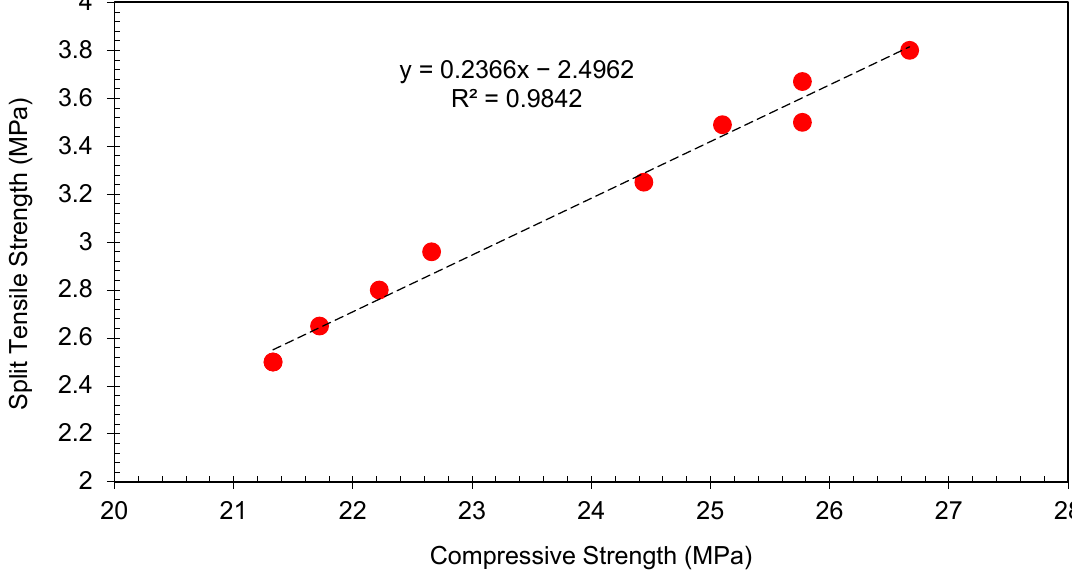
Figure 9. Correlation between compressive and split tensile strength (data source [58]).